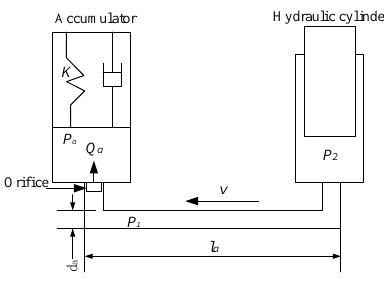
Figure 7. The accumulator system diagram.